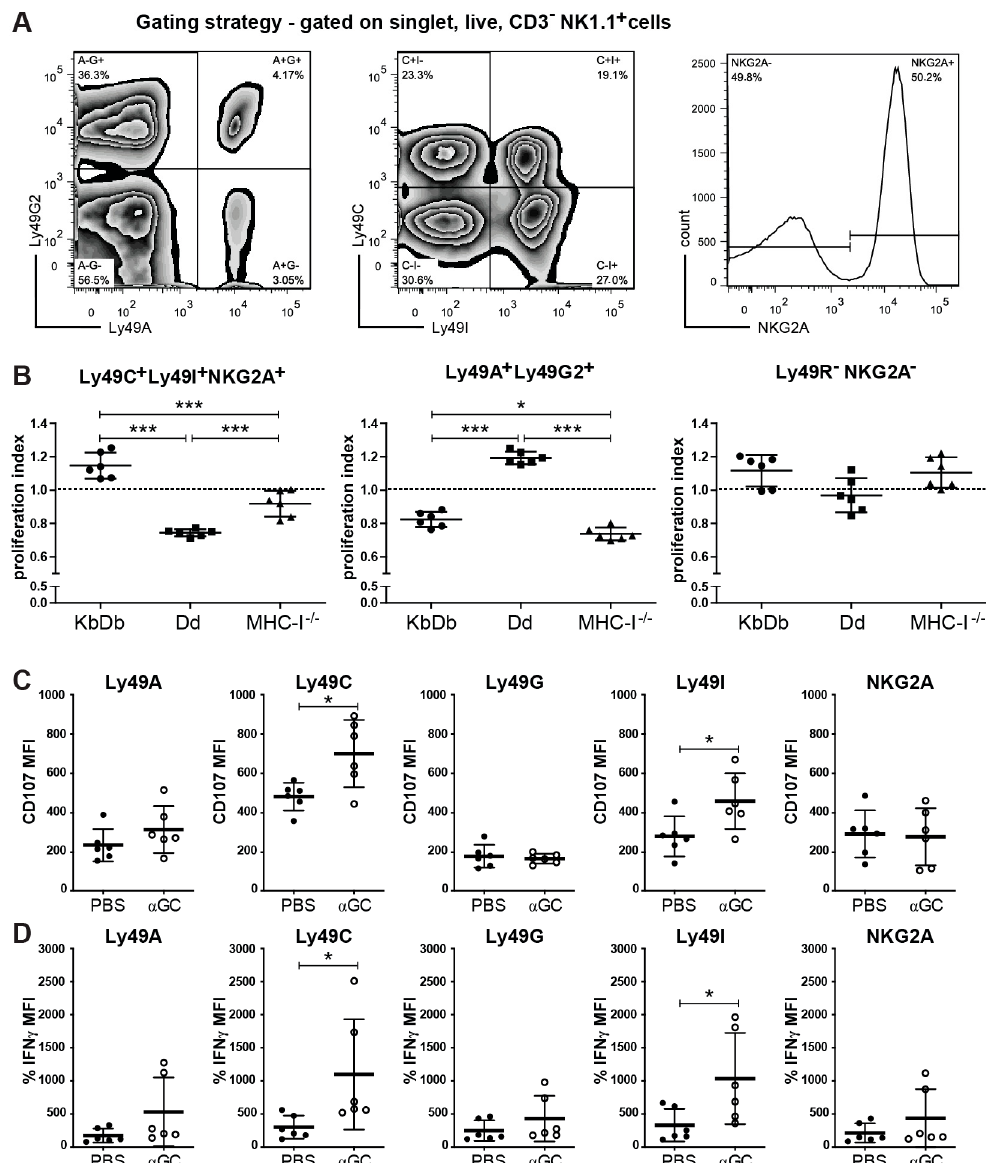
Figure 4. Selective proliferation of educated NK cell subsets after in vivo stimulation with α